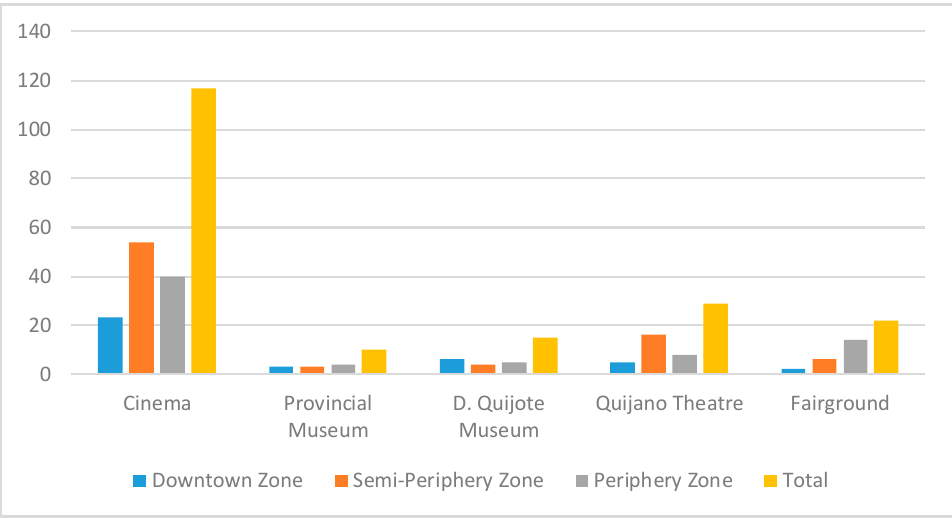
Figure 7. Results of answers related to city services. Source: Own work.